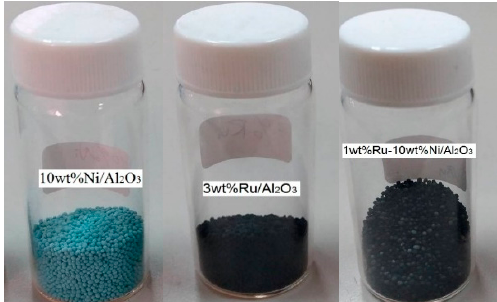
Figure 9. Prepared catalysts used in CO 2 methanation.